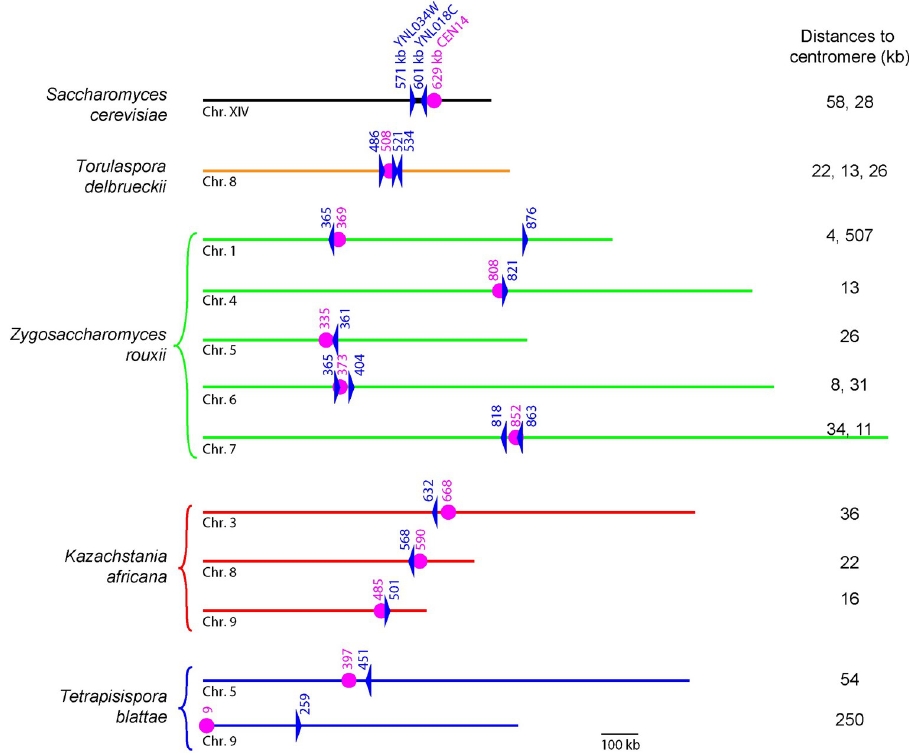
Fig 6. Locations of Centroid genes (homologs of YNL018C and YNL034W ) relative to centromeres, on budding yeast chromosomes. Blue triangles show the location and orientation of Centroid genes, pink circles represent centromeres, and numbers above these symbols indicate their position